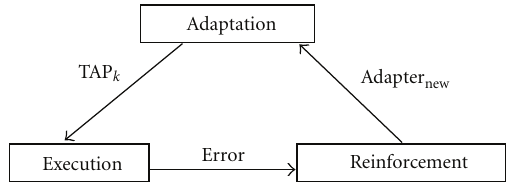
Figure 2: The adaptive game loop for the TAP adaptation frame- work. A cyclic process that enables online training for the adapters.